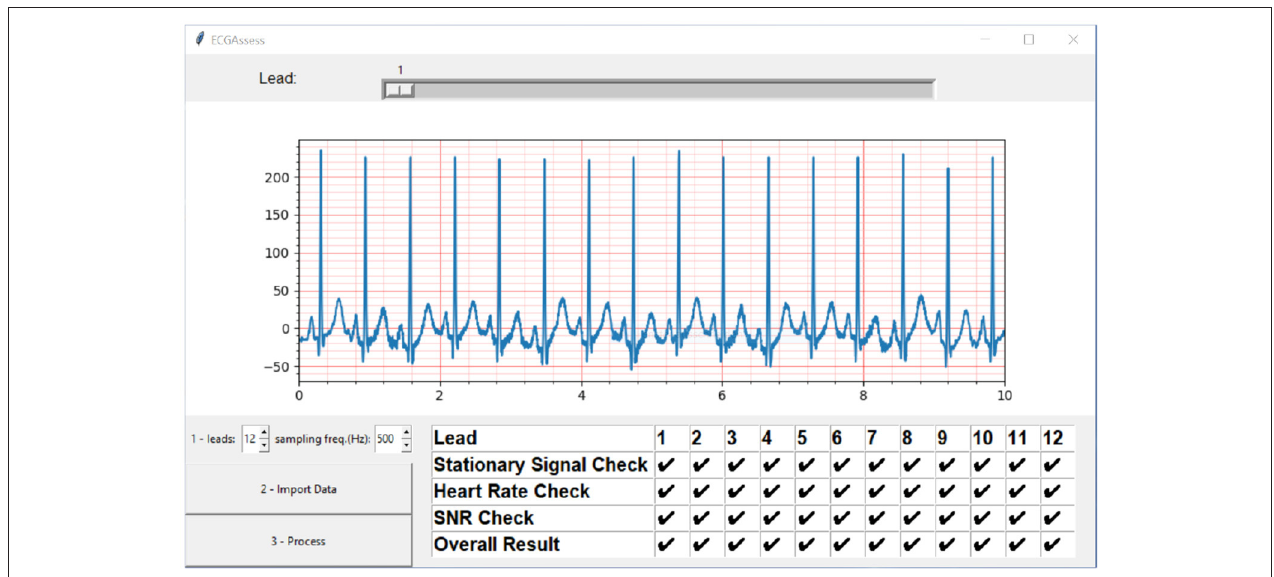
FIGURE 8 | ECGAssess toolbox output. The toolbox graphical user interface was developed to enable people without programming knowledge to use the application. Pressing the Import Data button opens an explorer window where the .txt file of interest can be selected. The signal is also visible in the plot window with the standard ECG grid, to improve the interpretation to cardiologists. The visible lead can be selected using the slider. When the “Process” button is pressed, the signal quality assessment is executed, and the results are displayed in a table